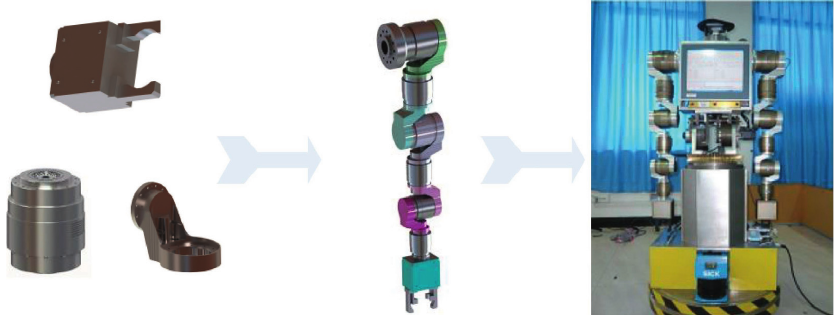
Figure 1: Model of the wheeled mobile dual-arm robot.